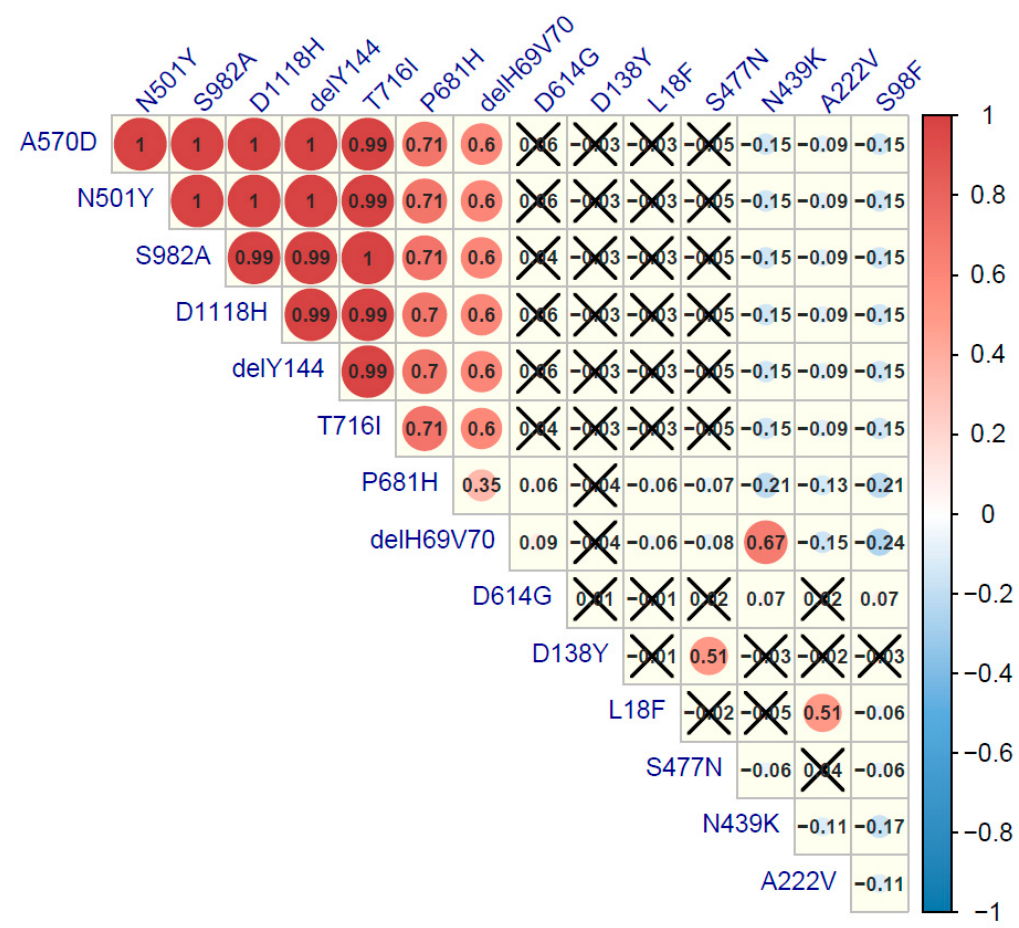
Figure 6. Correlation plot of major spike mutations in SARS-Cov-2 isolates from Poland. Positive correlations are displayed in red and negative correlations in blue. The color intensity and the circle size are proportional to the correlation coefficient values. Spearman’s rank test was performed, and a p -value ≤ 0.05 was considered as significant. Correlation coefficient values with greater p-value are cross-marked.